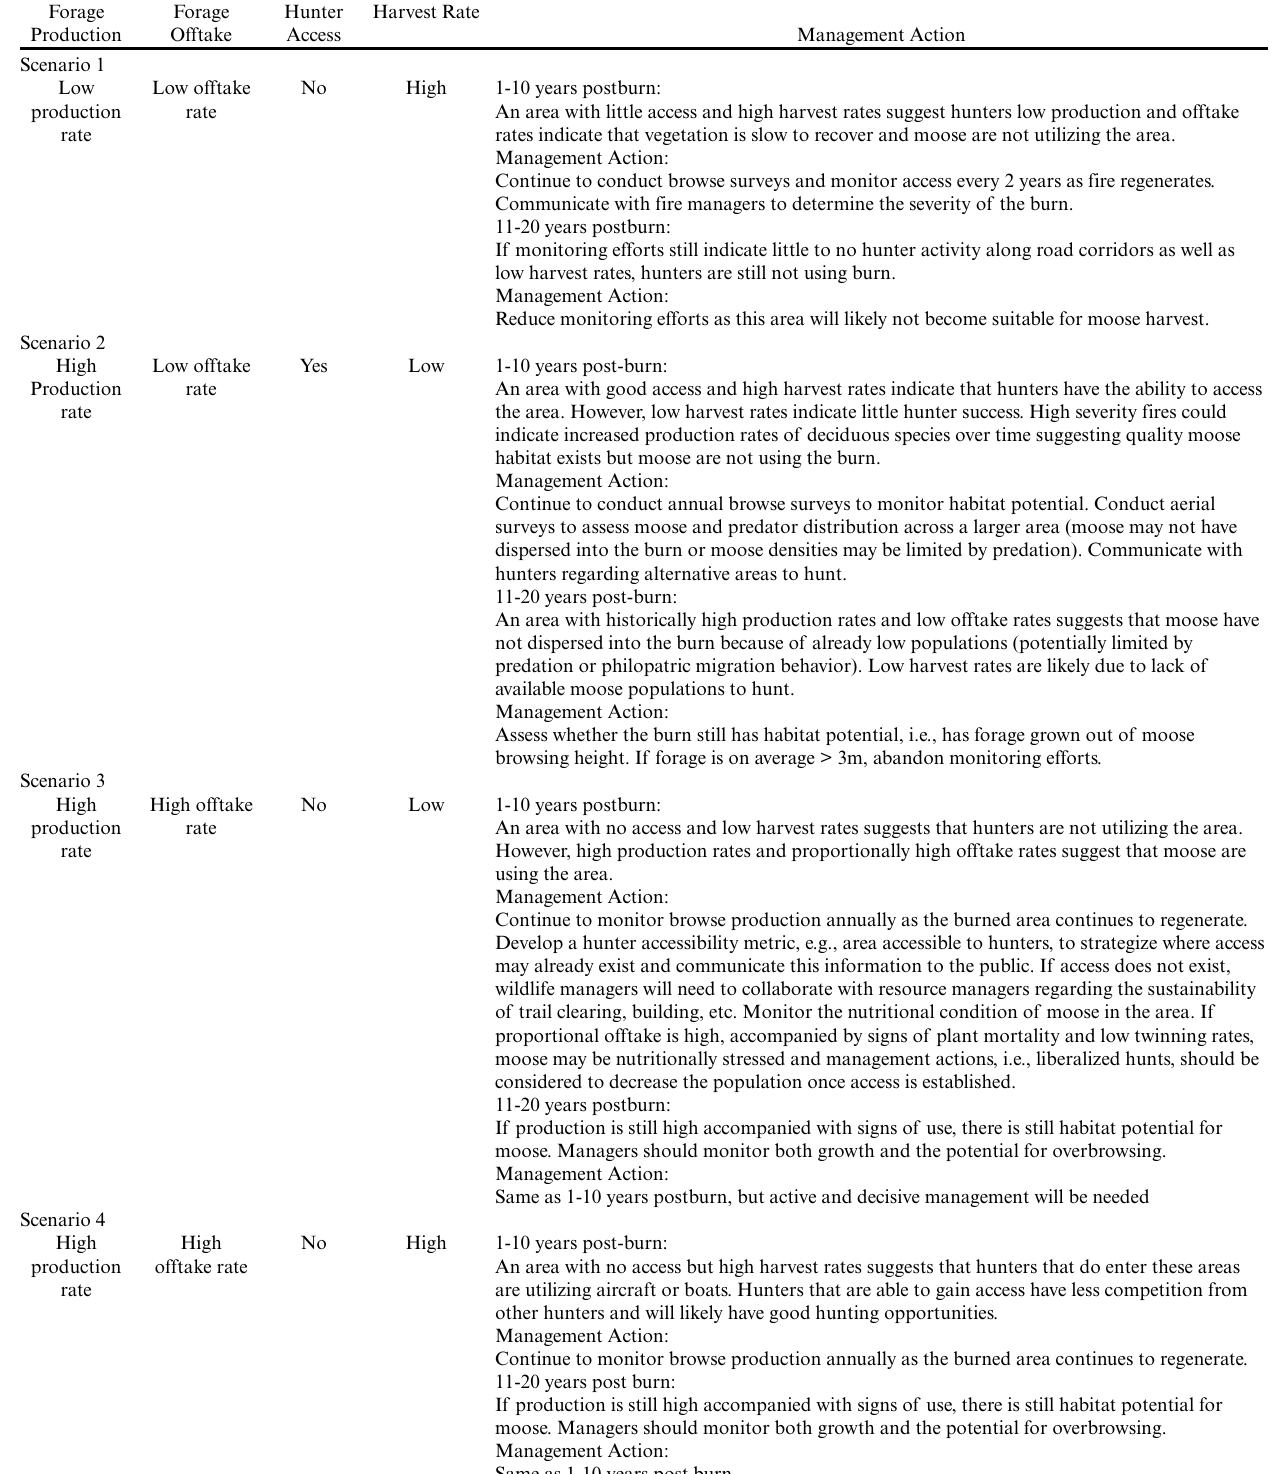
Table 2 . Management scenarios following a wildfire in interior Alaska. Each scenario includes a set of management actions at two different timescales postburn: initial prioritization (1-2 years) and continued monitoring (3-15 years). Initial prioritization allows managers to rank burns that have habitat potential for moose ( Alces alces ) and evaluate whether hunters will be able to utilize these areas in the future. Together these metrics allow managers to prioritize areas as high, moderate, or low for continued